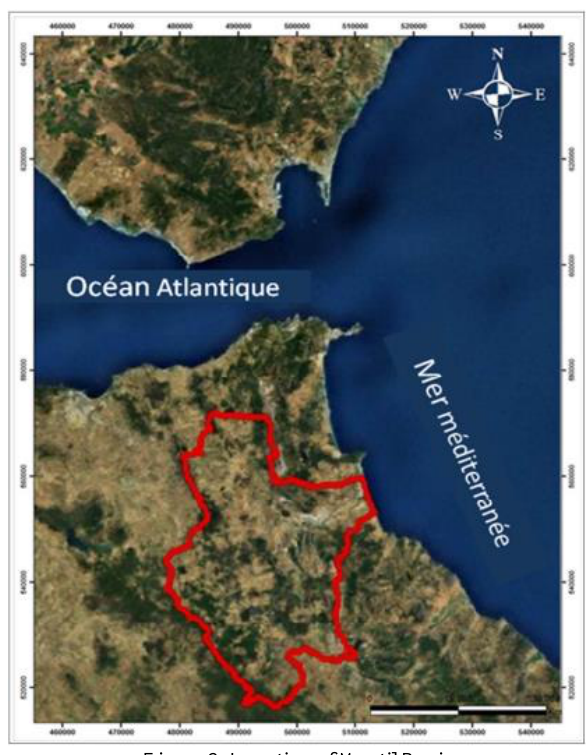
Figure 2. Location of Martil Basin